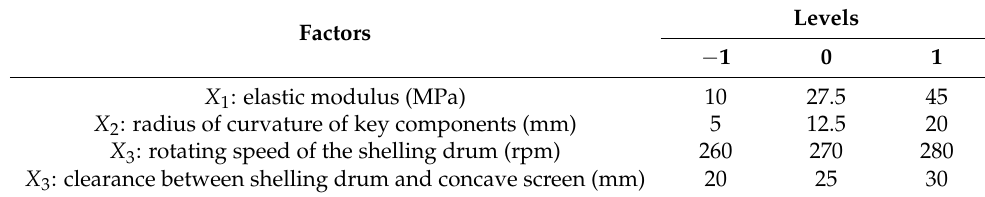
Table 2. Key parameters and levels of the experiment for MDR and SE.